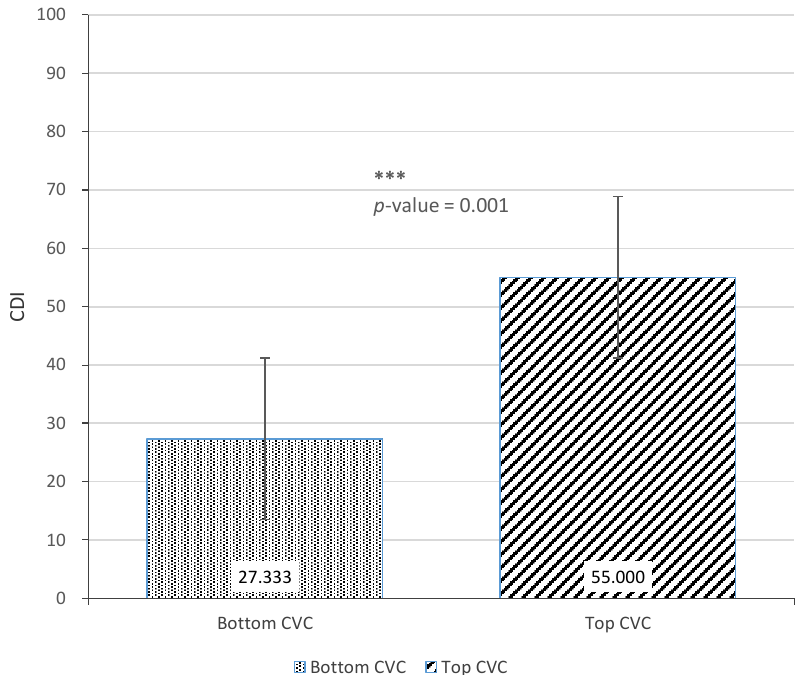
Figure 8. Difference in Communicative Development Inventories scores between top and bottom terciles of Child Vocalization Count. *** p < 0.01.